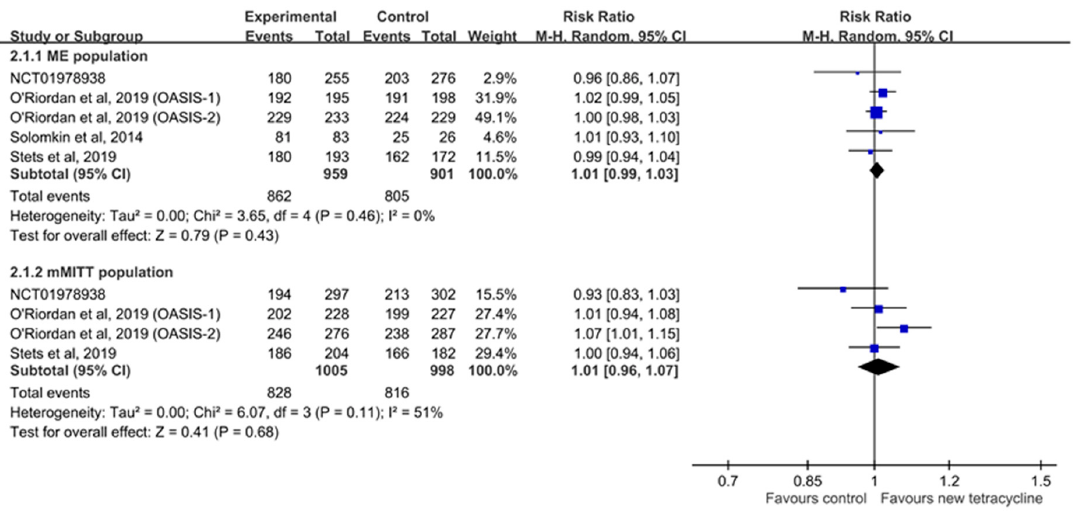
Figure 4. Forest plot of the microbiological response rate at the end of treatment visit between microbiologically evaluable (ME) and microbiologically modified intent-to-treat (mMITT) populations.